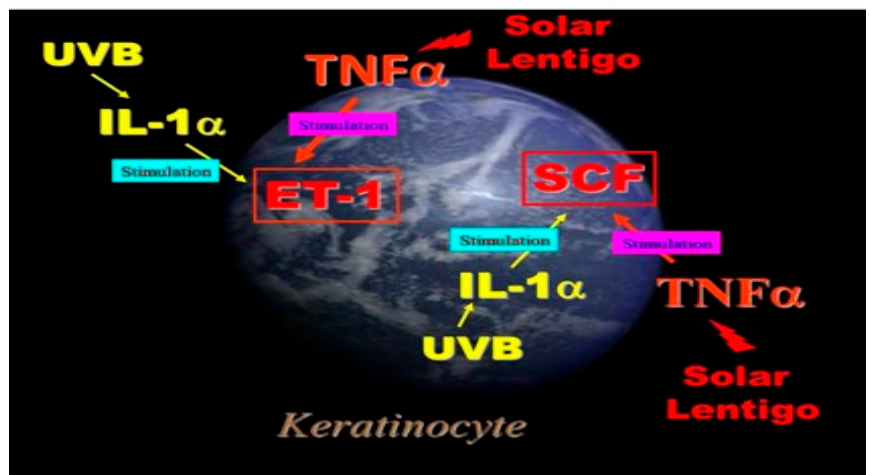
Figure 3. Autocrine cytokine linkages in UVB-exposed human keratinocytes and in the epidermis of SL.